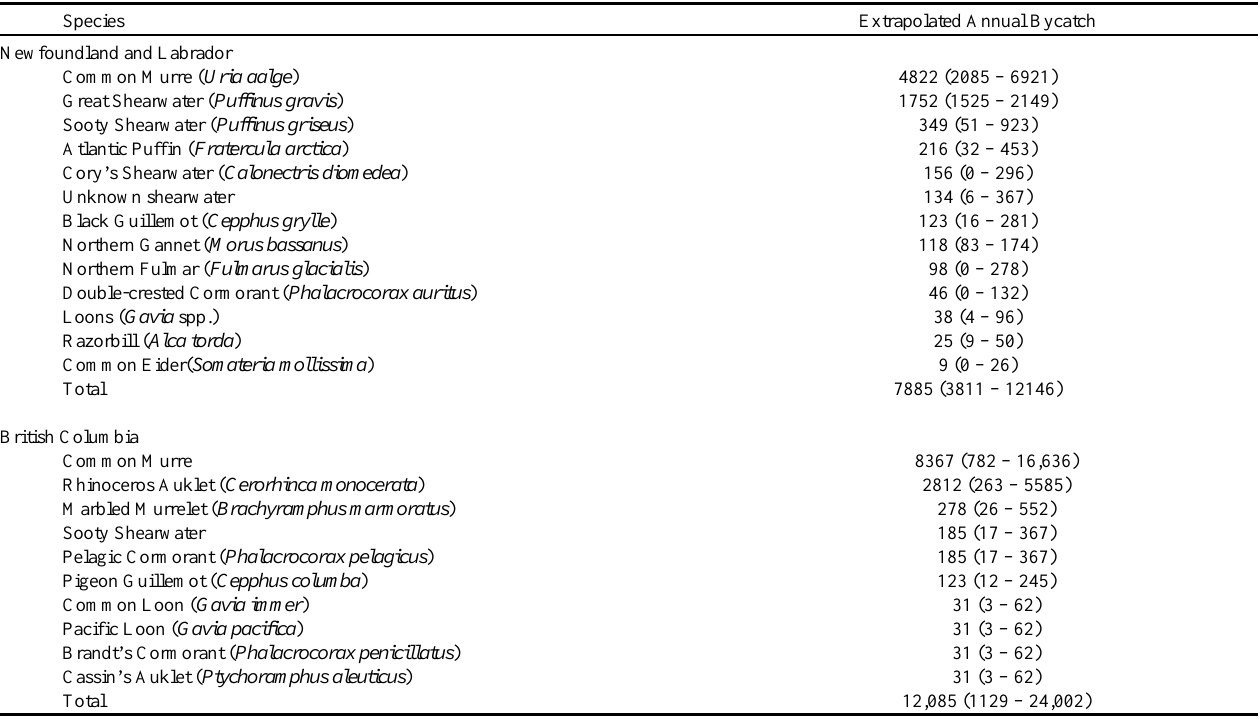
Table 4 . Extrapolated seabird bycatch for gillnet fishery in Newfoundland and Labrador (2001-2003; derived from Benjamins et al. 2008, mean with 95% CI in parentheses) and British Columbia (1995-2001; from Smith and Morgan 2005, mean with range in